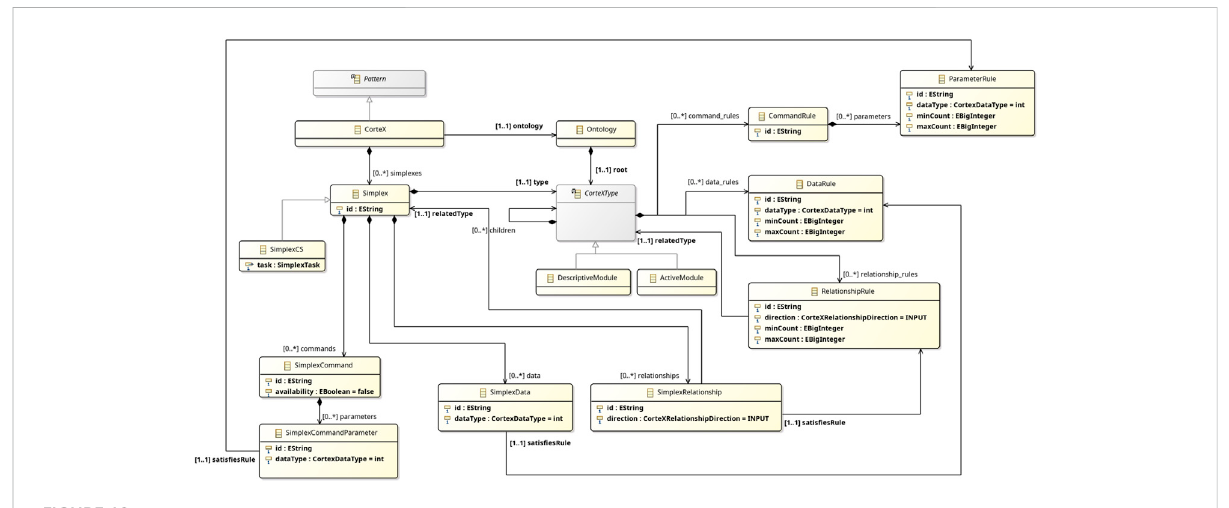
FIGURE 10 Metamodel of CorteX for integration with